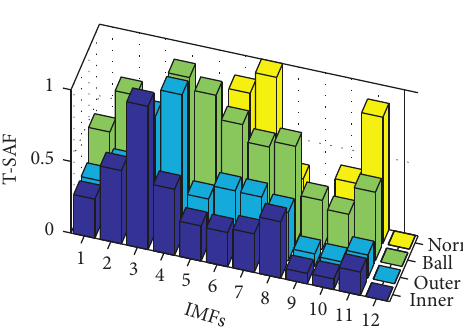
Figure 4: T-SAF values of the